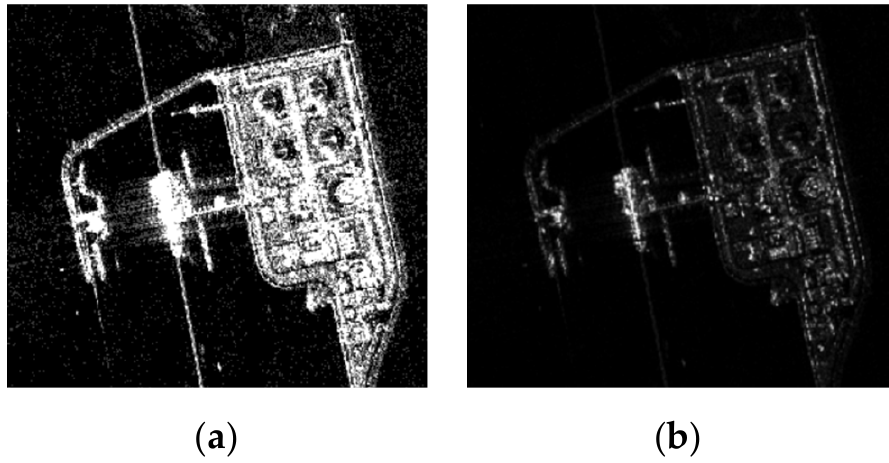
Figure 4. Illustration of improperly compressed SAR images; ( a ) is overexposed, and ( b ) is underexposed. Two kinds of data formats are described in Figure 5. The 8-bit compressed slices input to the detector were stored in PNG format. In Figure 5a, the R, G, and B channels indicate the amplitude value of the covariance matrix elements C 11 , C 12 , and C 22 . For convenience, the quantification was completed by an algorithm embedded in the SNAP